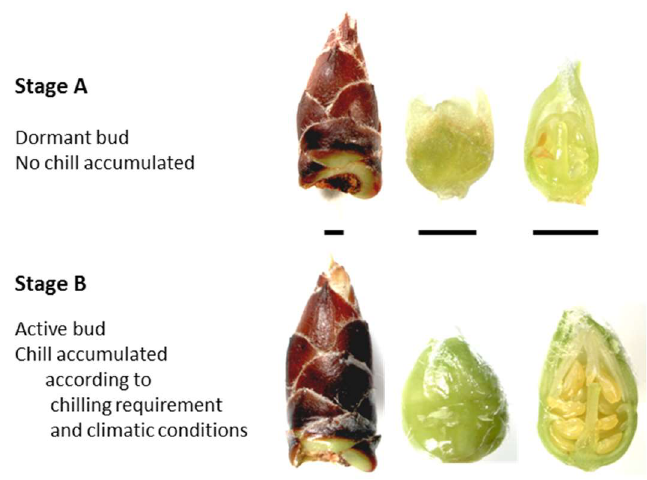
Figure 6. Plant material from ‘Desmayo Largueta’ and ‘Penta’ almond cultivars. Flower buds in the dormant state ( A ) and after dormancy release ( B ) according to Felipe [41]. Scale bars represent 1 mm in each case.